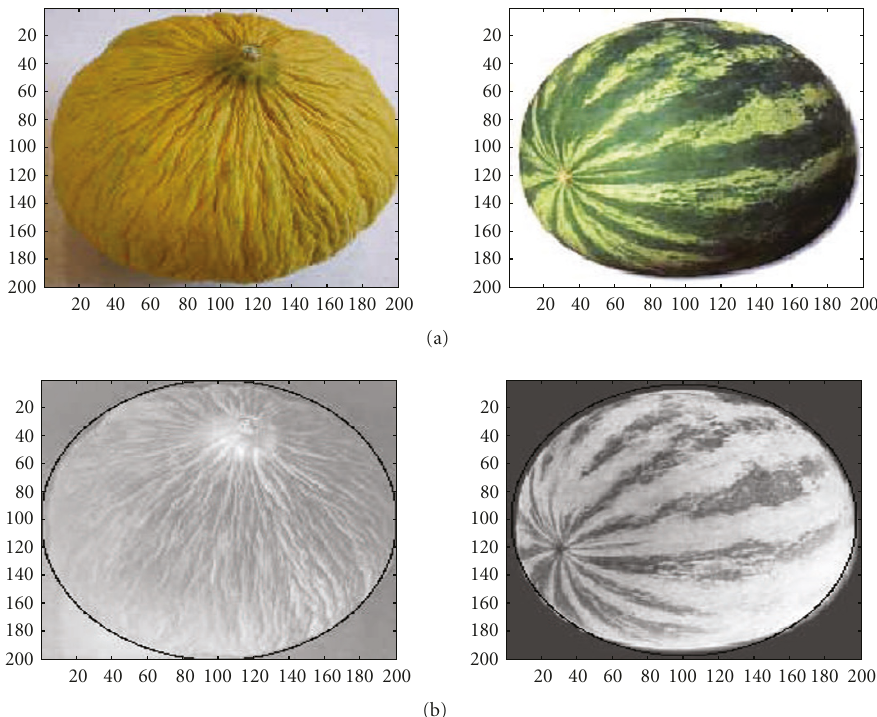
Figure 6: (a) Processed image, (b) result obtained with the proposed method for radius estimation. ME ρ = 0 . 4 and 0 . 6 pixel.